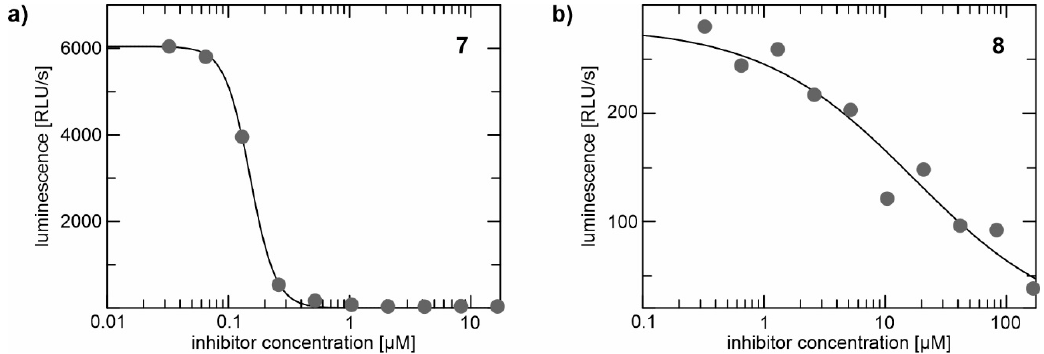
Figure 12. Anti-trypanosomal activity of the ( a ) benzyl ester 7 and ( b ) acid 8 measured by the ATPlite assay. Shown is luminescence (RLU/s = relative light unit per second) in dependence of compound concentration.